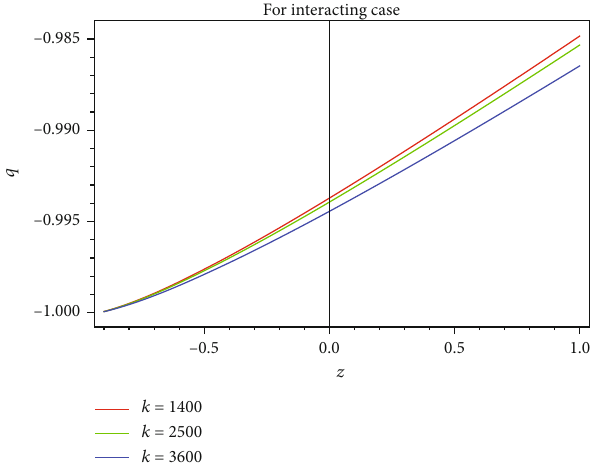
Figure 2: Behavior of q against z